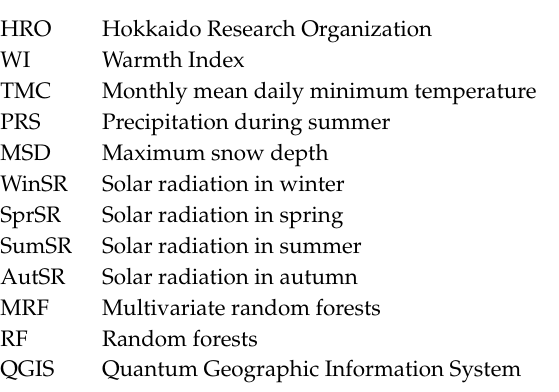
s1, Table S1: List of seed zones and regional groups of A. sachalinensis in Hokkaido, Japan, Table S2: Climatic conditions of testing sites, Figure S1: Relationships between observed and predicted tree heights, Figure S2: Predicted tree heights at 10 years after planting in each provenance region, Figure S3: Difference of predicted tree height between using optimum and local seed sources, Figure S4: Averaged survival rate (left panels) and tree height with standard deviation (right panels) of transplants for each of the regional groups at each test site, Code S1: The code for developing a multivariate random forests (MRF) in